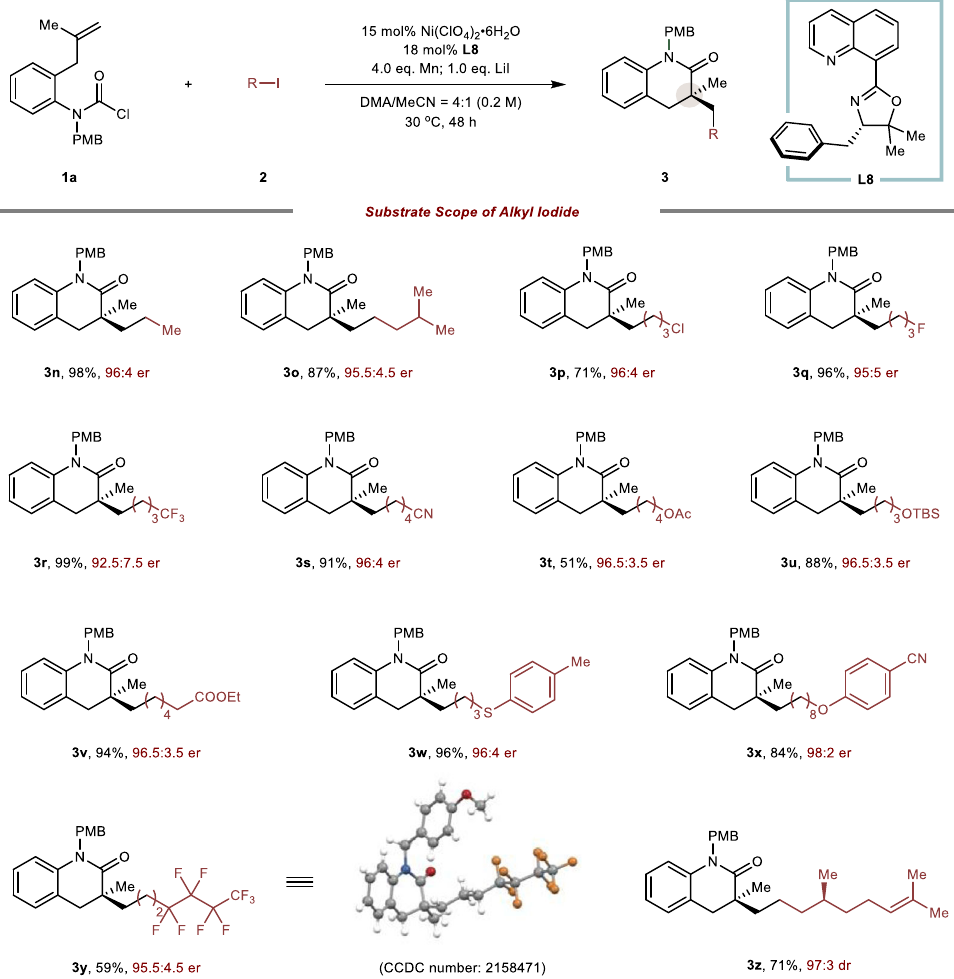
Fig. 4 | Substrate scope of alkyl iodide. The reaction was performed with carba- moyl chloride 1a (1.0 eq.), iodide 2 (3.0 eq.), Ni(ClO 4 ) 2 (cid:129) 6H 2 O (15mol%), L8 (18mol %), Mn (4.0 eq.), LiI (1.0 eq.), DMA/MeCN (v/v=4/1, 0.2M), stirred for 48h